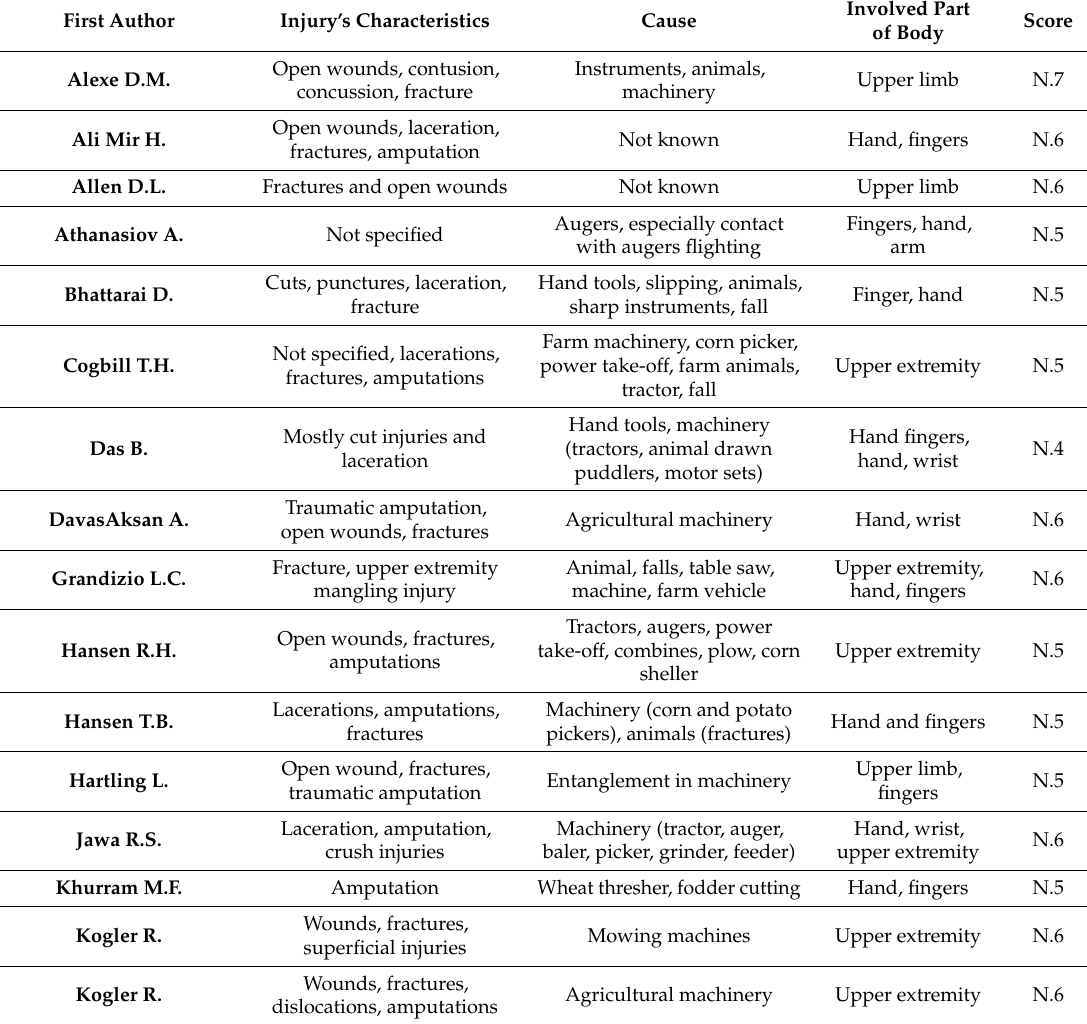
Table 3. Cross articles with relative